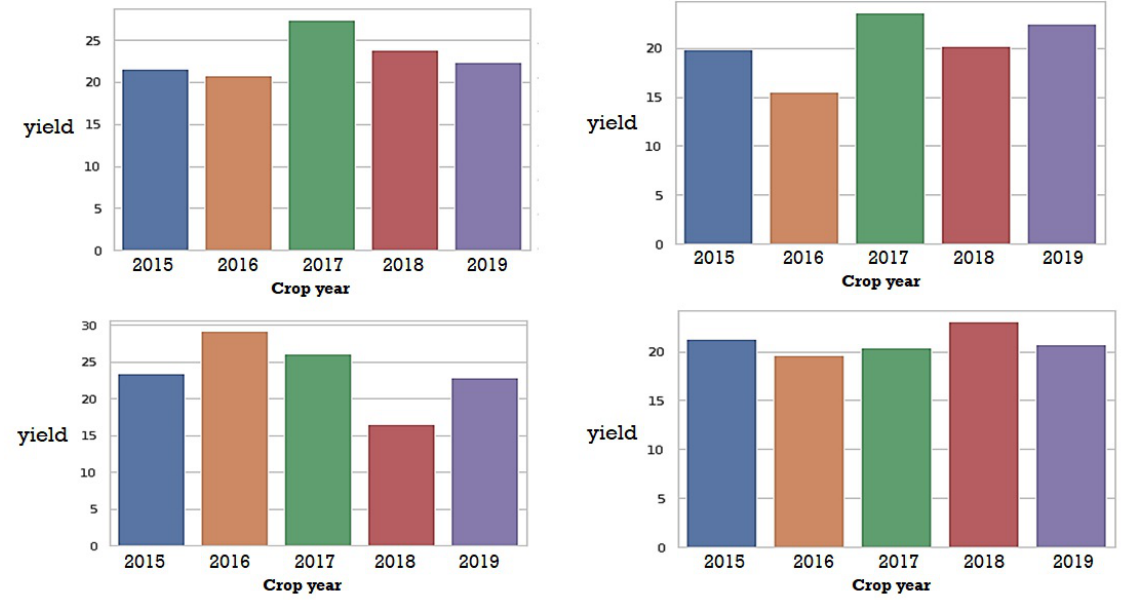
Figure 4. Distribution of yield over the five years of study (a sample of four